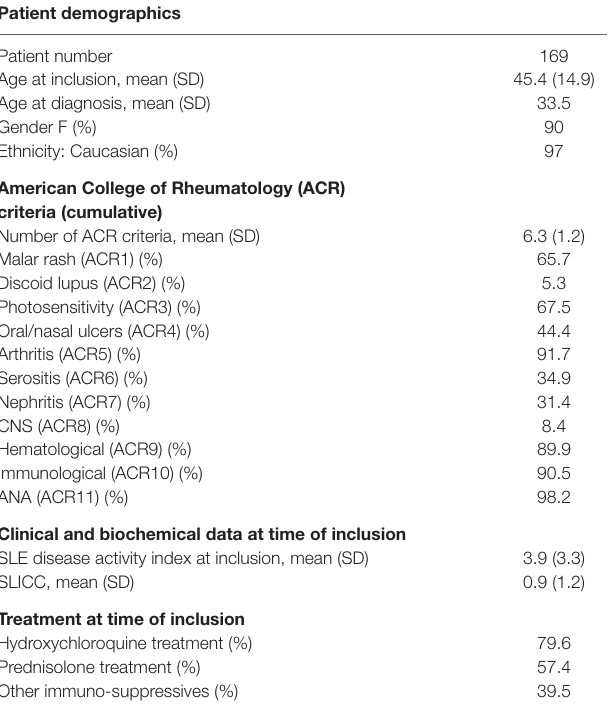
TaBle 1 | Systemic lupus erythematosus patient